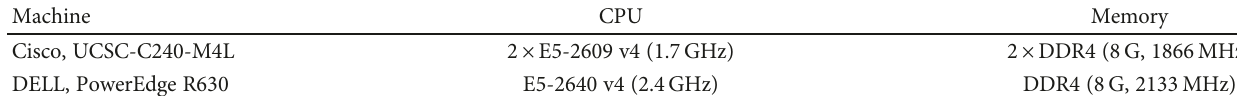
Table 6: The hardware environment of the